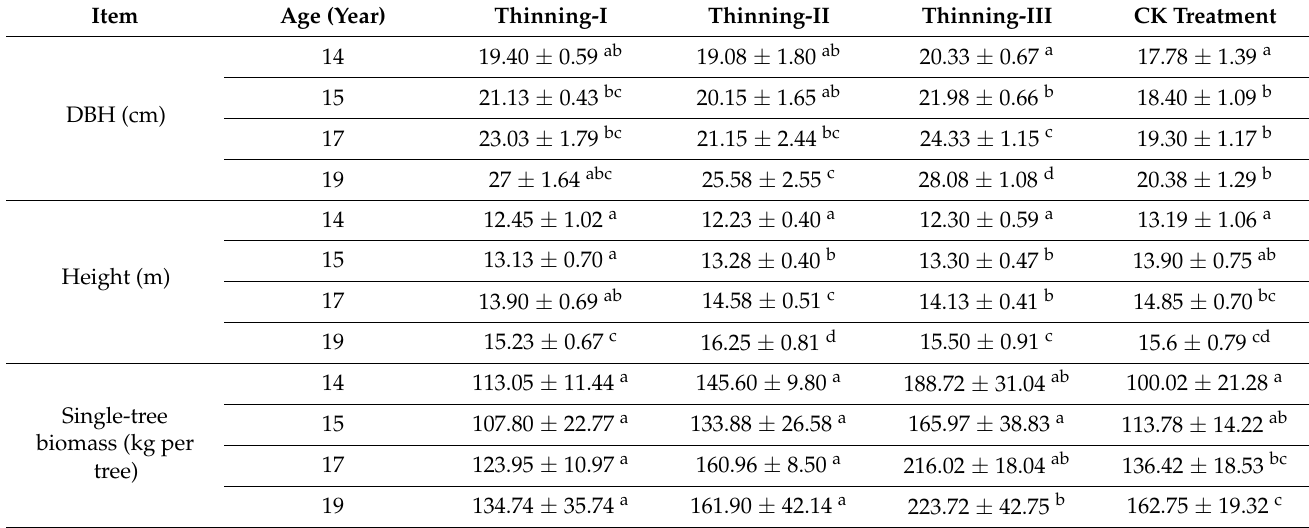
Table 1. Stand characteristics of C. lanceolata plantations under different thinning intensities.